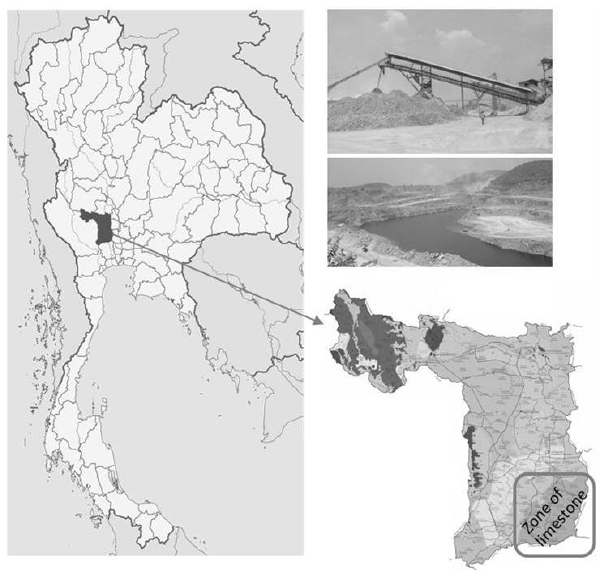
Fig. 3. Geological map of research case study, Central of Thailand